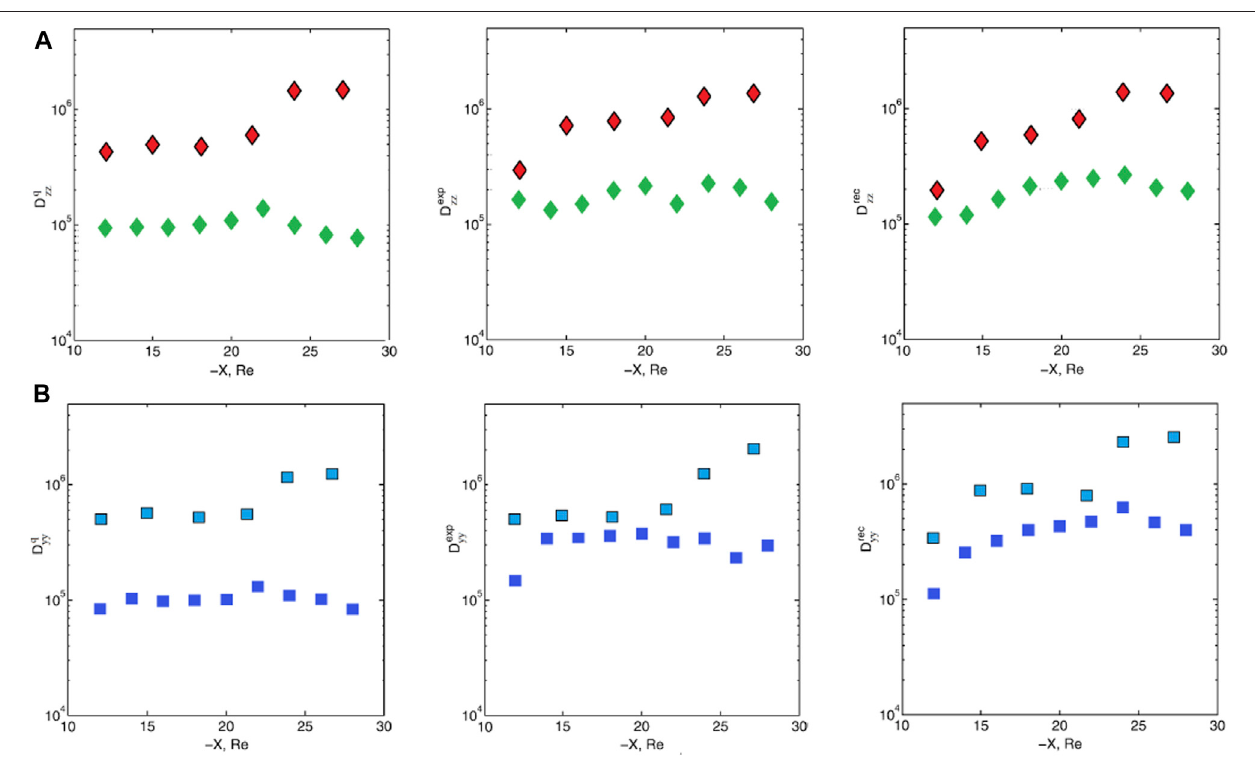
FIGURE3| Comparisonofthedependenciesof D zz (A) and D yy (B) ontheradialdistanceandonthephaseofmagnetosphericsubstorm(q,quiet;exp,expansion; rec, recovery) from (Stepanova et al., 2009) (red diamonds and blue squares) and (Stepanova et al., 2011) (green diamonds and dark blue